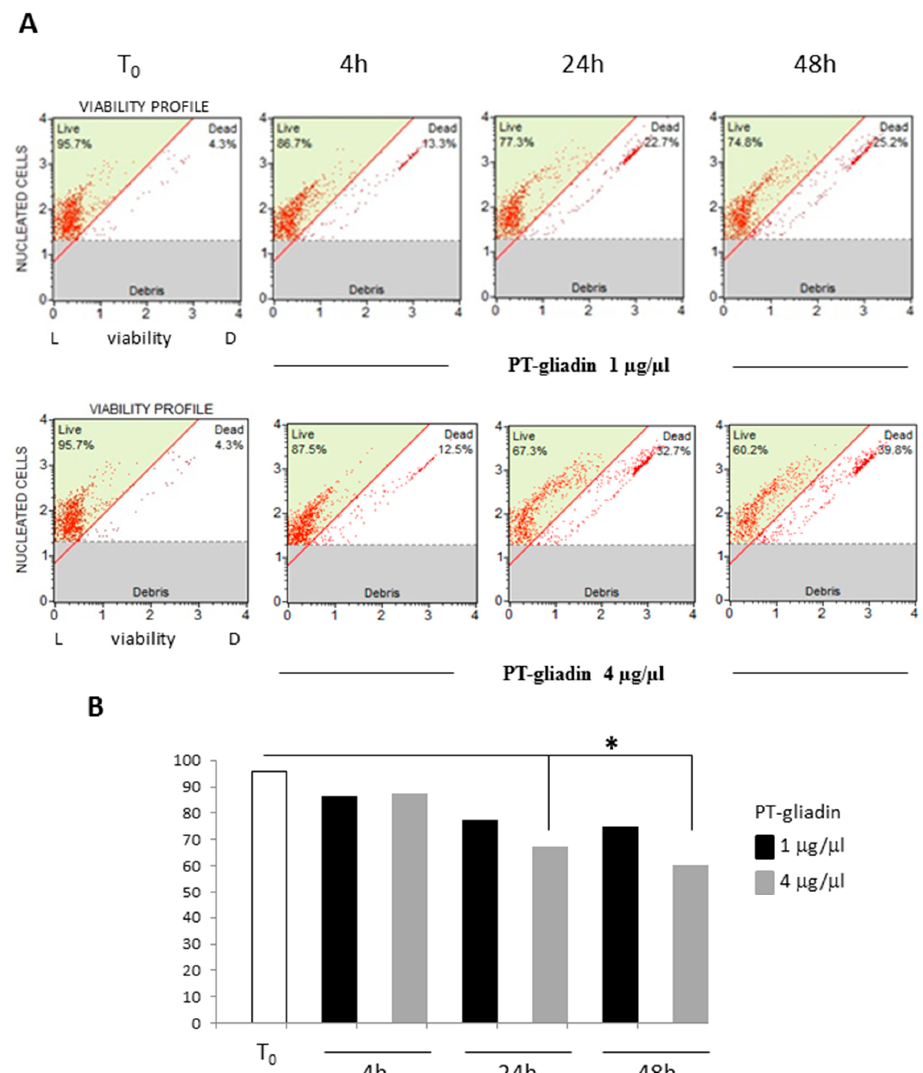
Figure 6. Viability assays after PT-gliadin administration in Caco-2 cells. ( A ) Cytofluorimetric plots of viability profiles (L: cells live; D: cells death) summarized in Panel ( B ) (asterisk indicates p < 0.05, Anova One-way, compared to T 0 untreated sample).